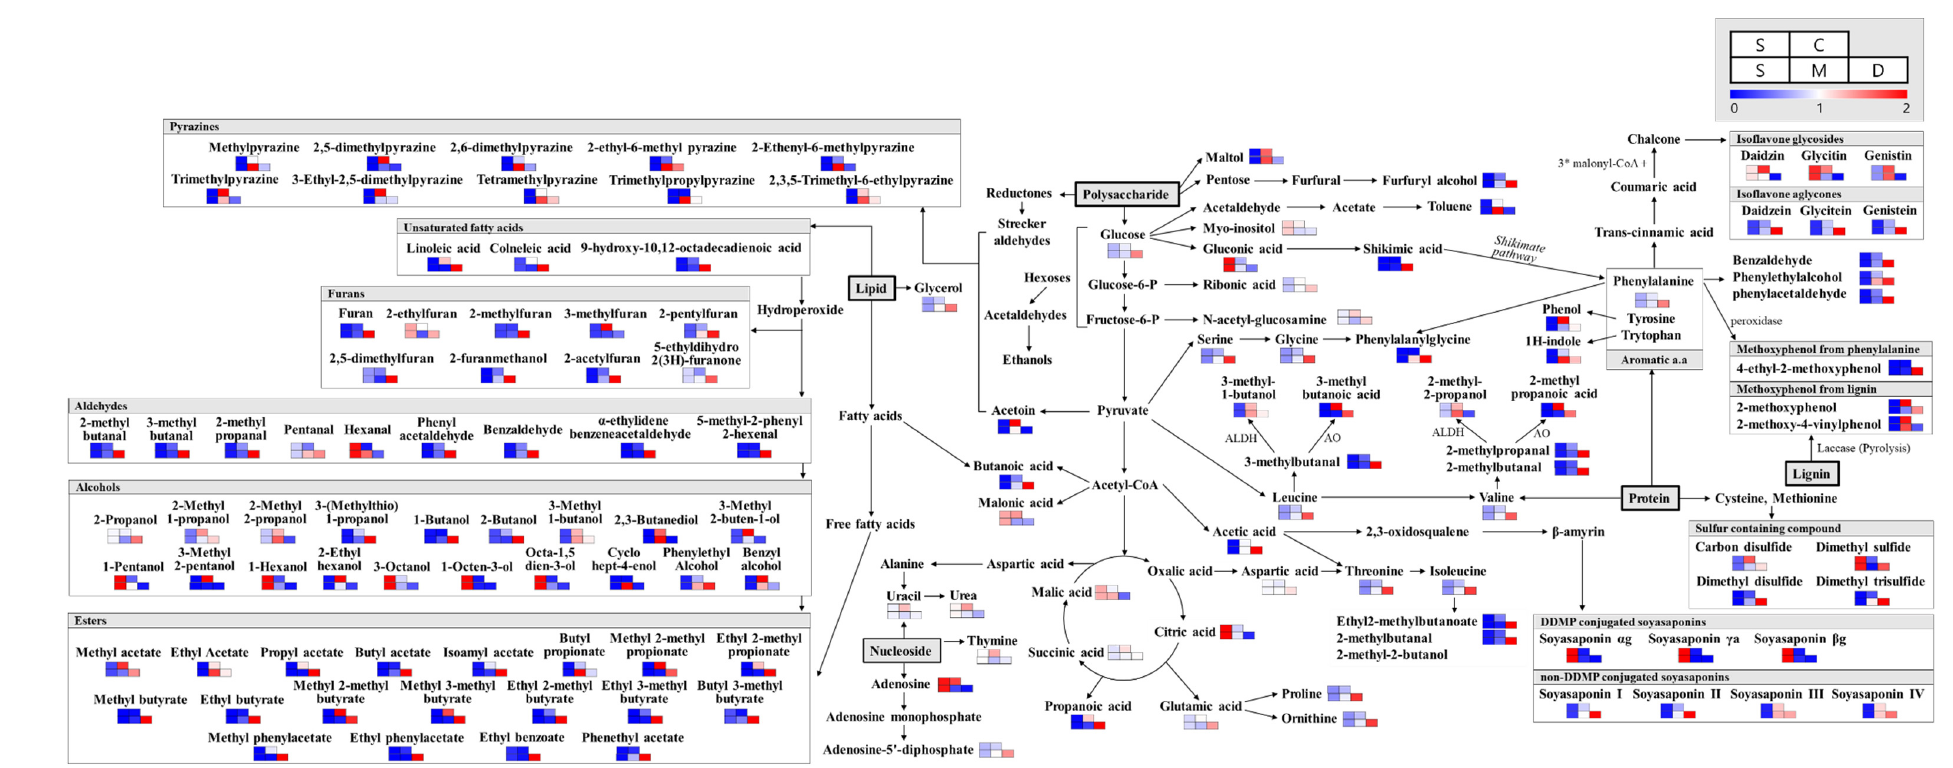
Figure 3. Schematics showing the relative abundance of the significantly discriminant metabolites (primary and secondary metabolites, as well as VOCs), detected comprehensively from the fermented soy foods (cheonggukjang, meju, and doenjang) and unfermented soybean. The metabolites are shown in the form of biosynthetic pathways, adapted from the Kyoto Encyclopedia of Genes and Genomes (KEGG) database, relatively higher in cheonggukjang. Nucleotide compounds were relatively more abundant in cheonggukjang.